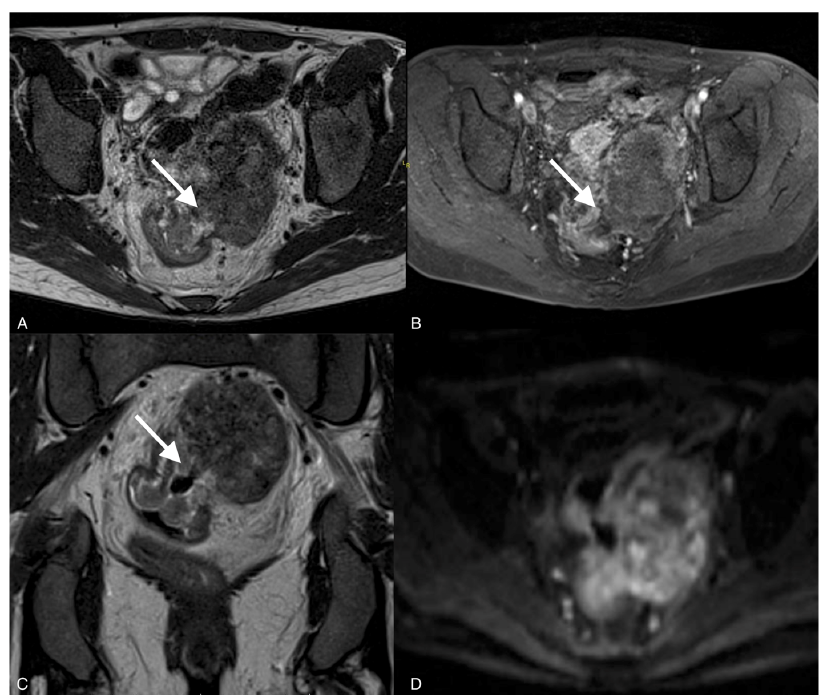
Figure 4. Images of a 37-year-old woman with a recurrent tumor of high-grade serous ovarian cancer with fistula between tumor and sigmoid colon. MRI T2-weighted images obtained in axial plane ( A ), coronal plane ( B ), and T1 post-contrast ( C ) show a large solid/cystic tumor and the fistula (arrows) between tumor and sigmoid colon. DWI (b1200) shows restricted diffusion in the tumor but not in the fistula ( D ).